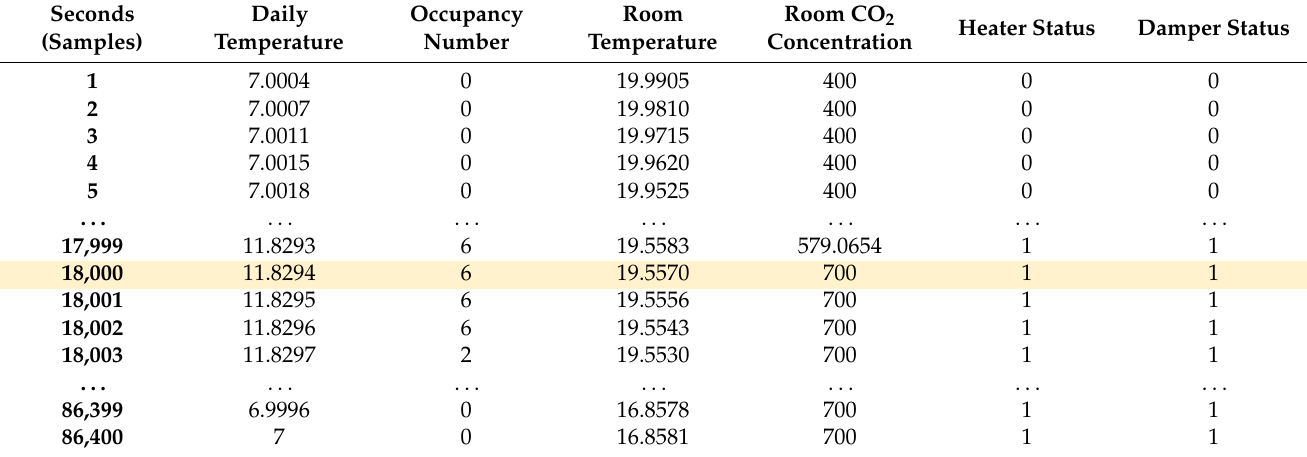
Table 13. Use-case RDT for CO 2 sensor fault in 18,000 s Fault (The Background color shows the fault injection time sample). Seconds